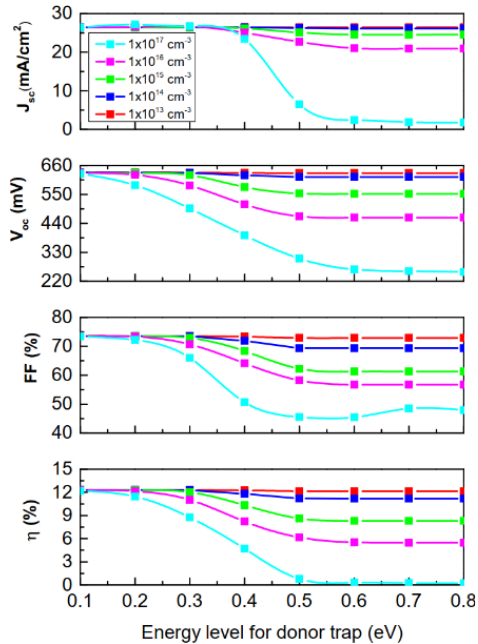
Figure 8. Cell parameters as a dependence of energy level for acceptor trap from 2D simulations for different defect densities.